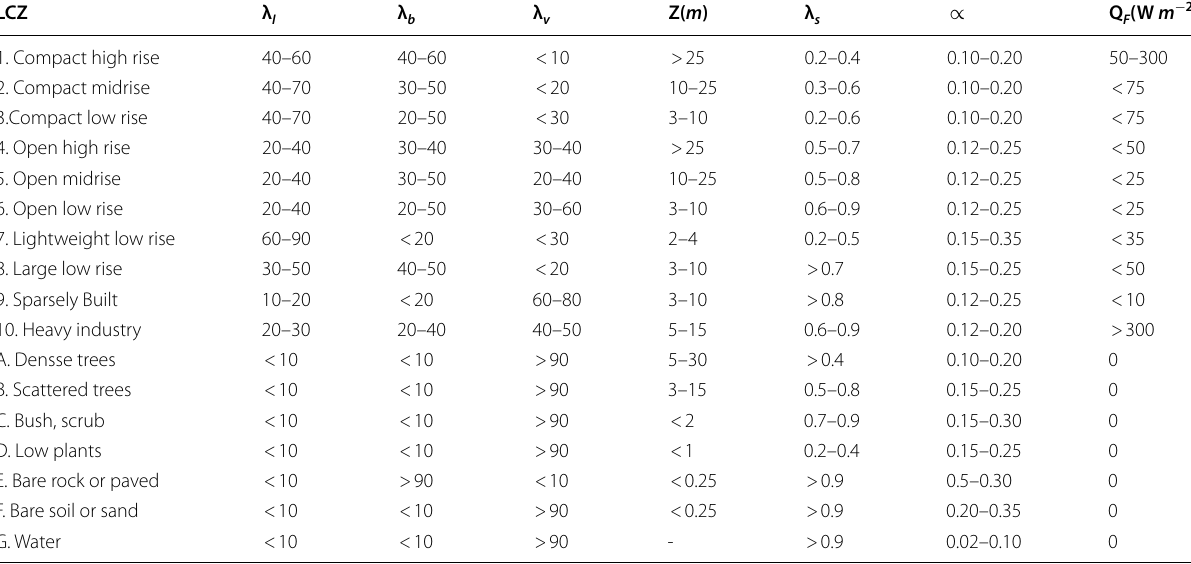
Table 4 Some of the UCP values associated with LCZ types from Stewart and Oke (2012). Columns represent the percentage